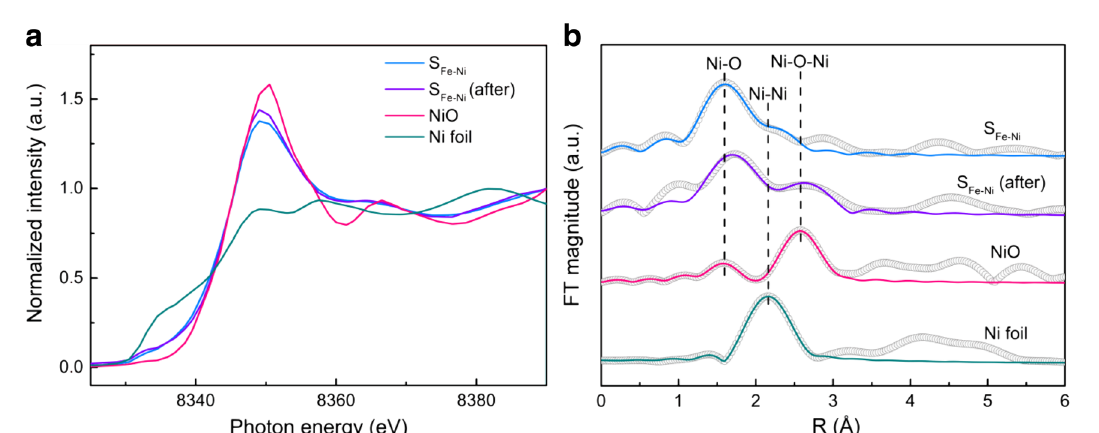
fi tting results of the fresh and used S Fe-Ni catalyst. The black open circles show the original data of the EXAFS spectra, while the lines of other colors are the